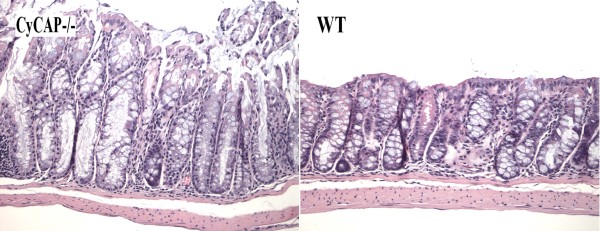
The differences in the crypt length and crypt cell content are more obvious between WT and KO animals after the treatment by azoxymethane. After the treatment by azoxymethane, the CyCAP-/- mice develop more extensive mucosal hyperplasia of the colon than WT animals (p < 0.0001, T-test). The mononuclear inflammatory content in the lamina propria is not increased compared to WT animals (20 × magnification, H&E).